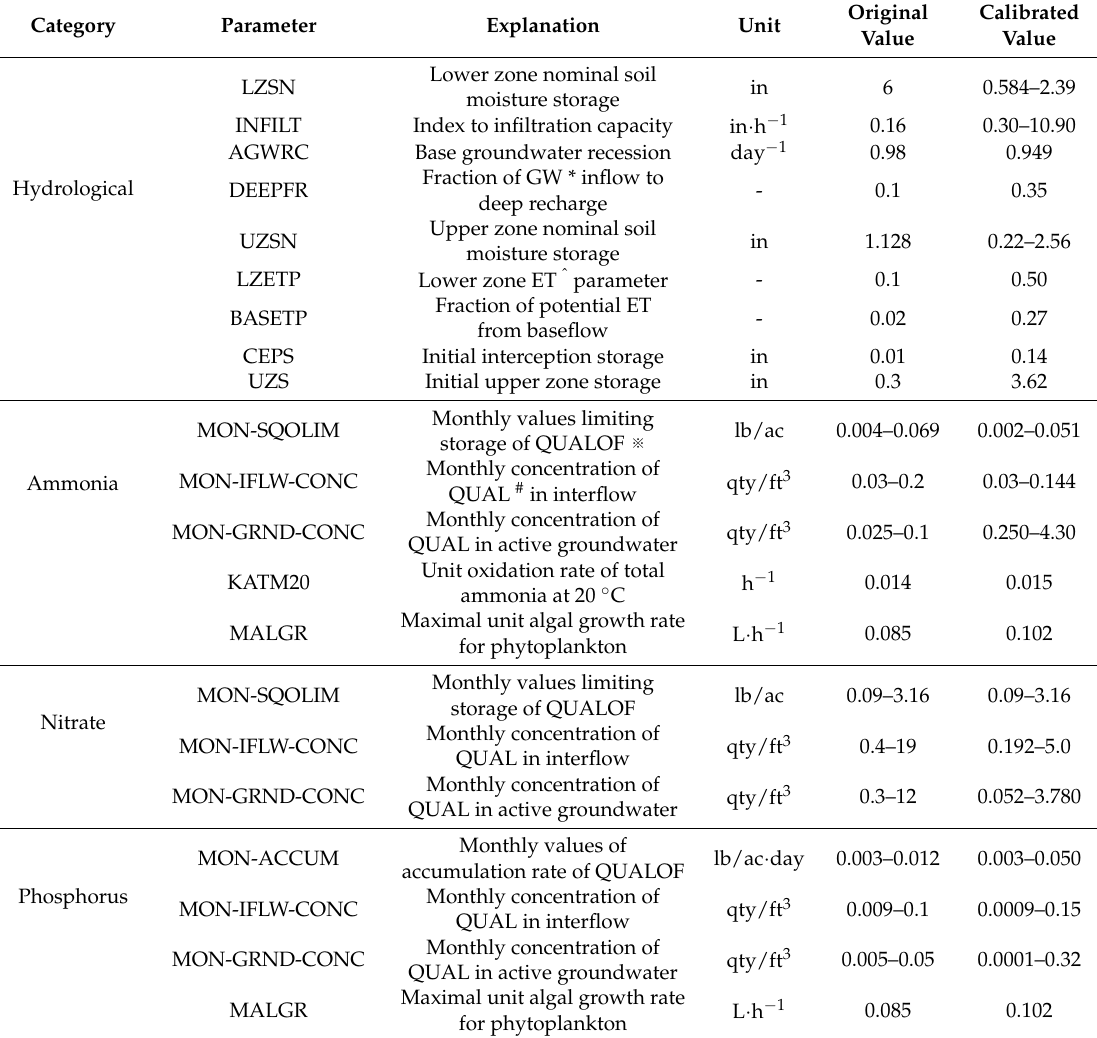
Table 1. List of adjusted parameters for calibration of HSPF (Hydrological Simulation Program–Fortran) model.